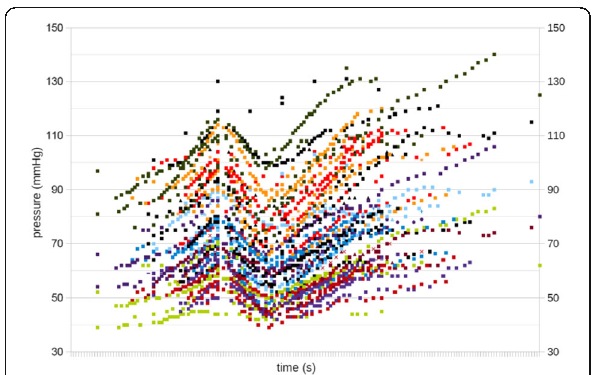
Fig. 1 (abstract A16). Triphasic pattern. Pressure trend after etilefrine administration (n=27). Data synchronized with the first BP peak